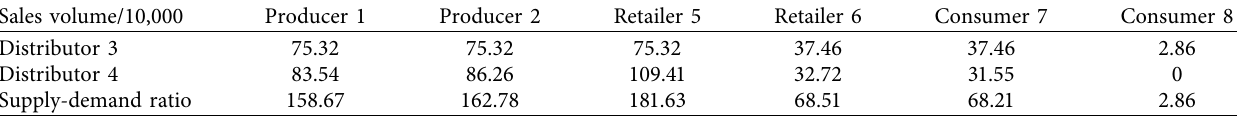
Table 4: Green product sales volumes in the GSCDN after the adjustment of cost functions.